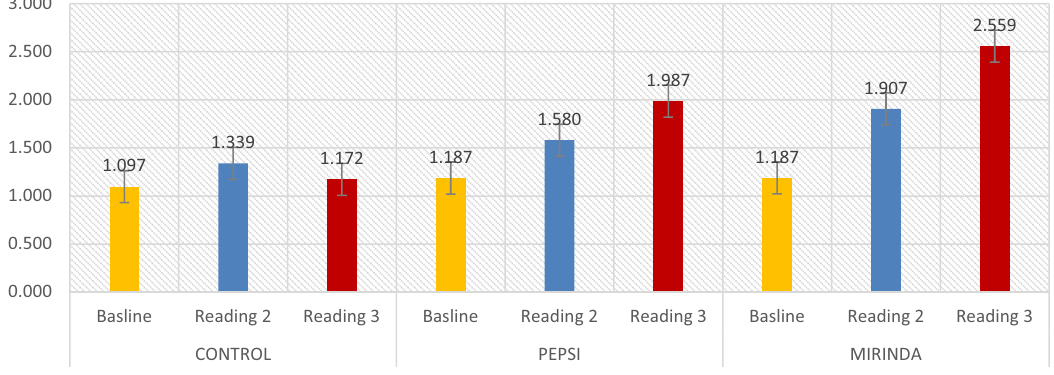
Figure 2. Surface roughness reading within each